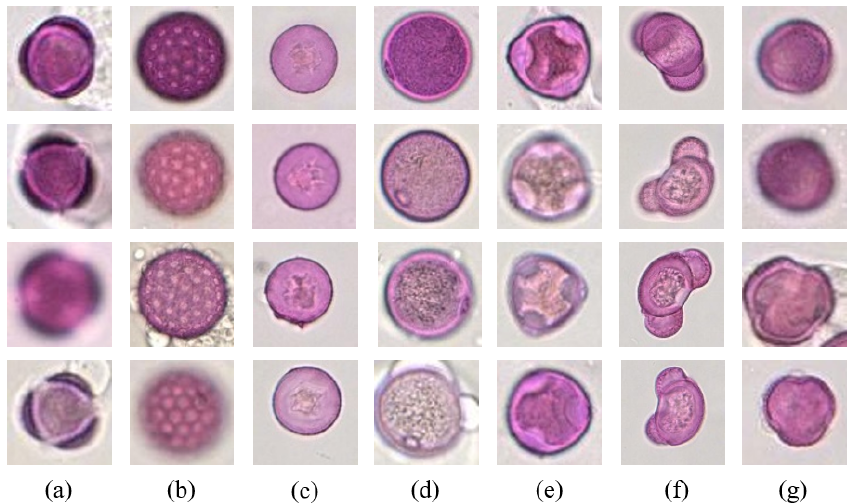
Figure 3. Several example pollen grain images: ( a ) Artemisia ; ( b ) Chenopodiaceae; ( c ) Cupressaceae; ( d ) Poaceae; ( e ) Moraceae; ( f ) Pinaceae; ( g ) Salix .